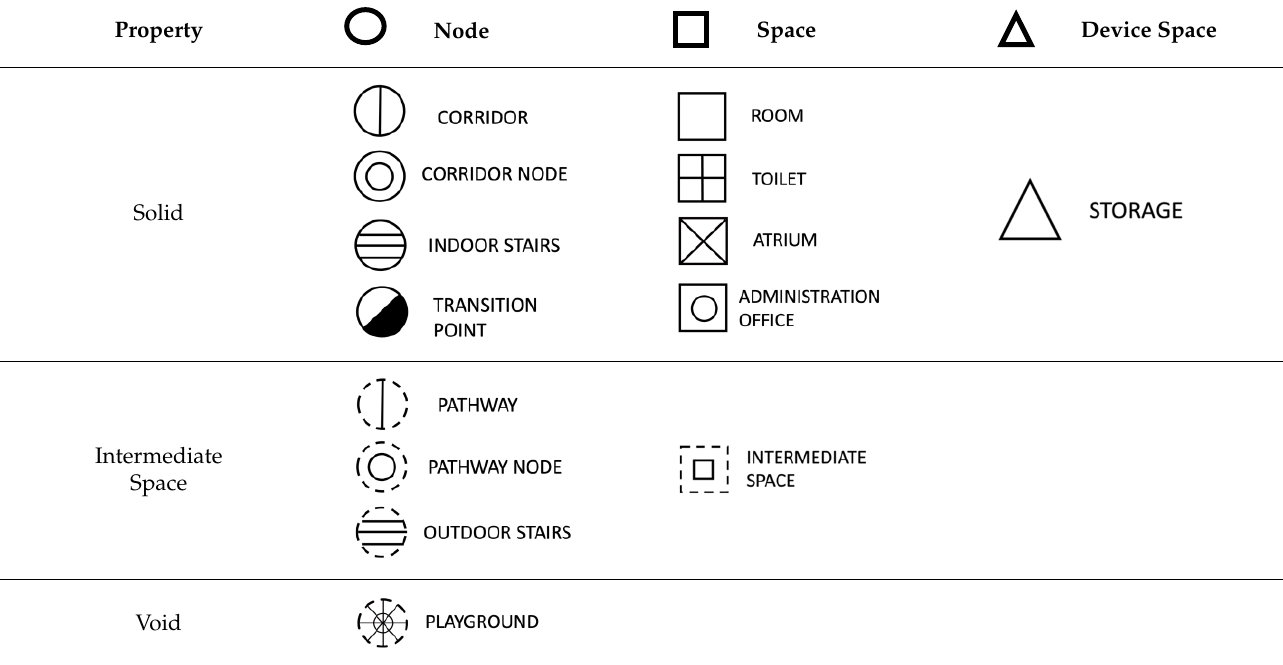
Table 3. Legend Charts.